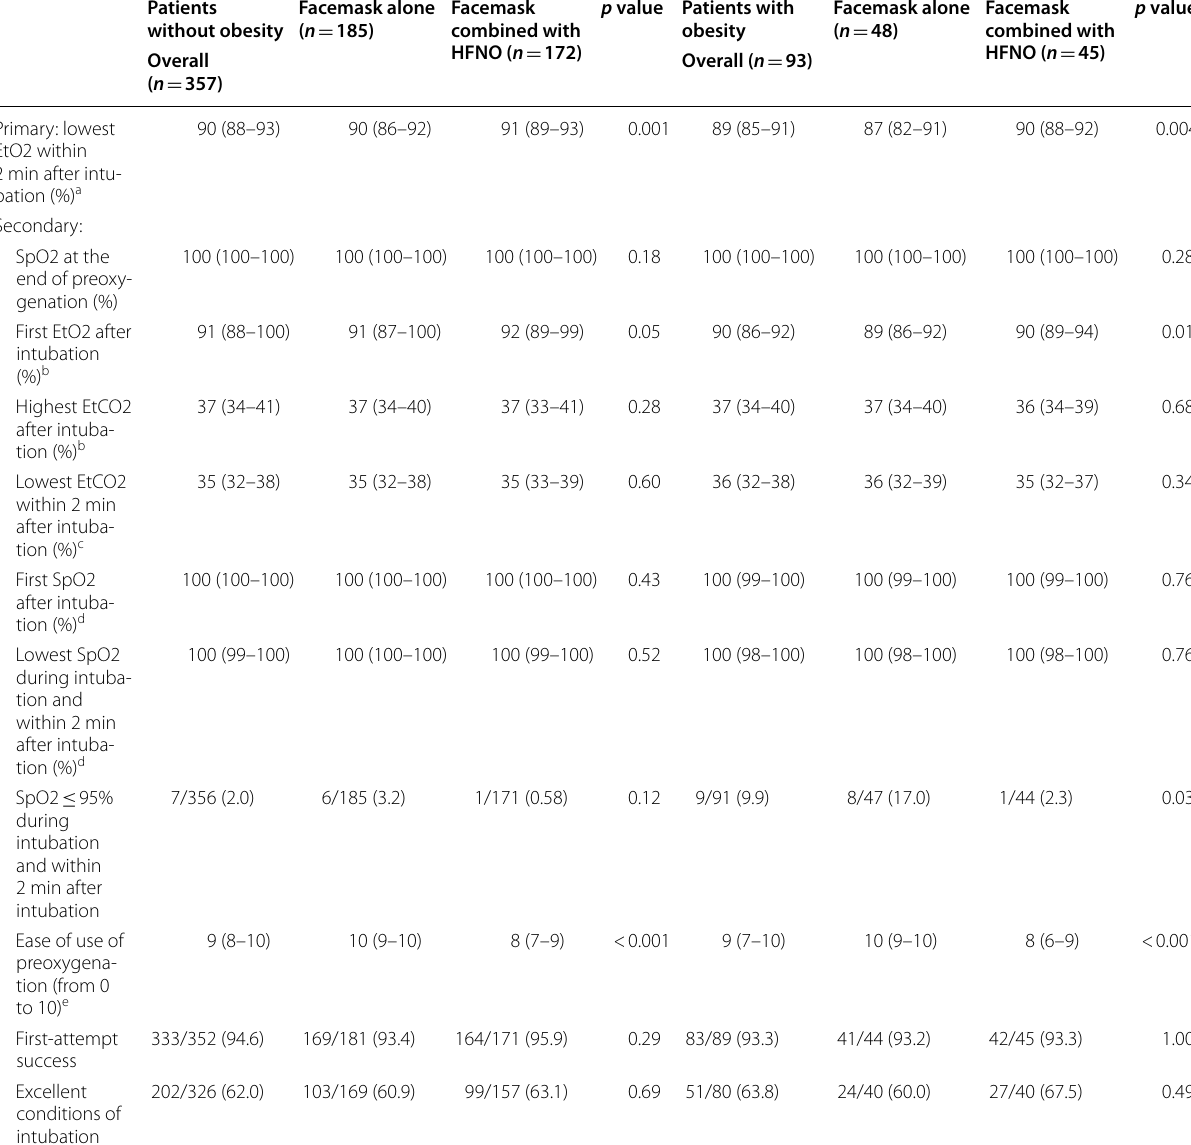
Table 4 Outcomes according to the obesity